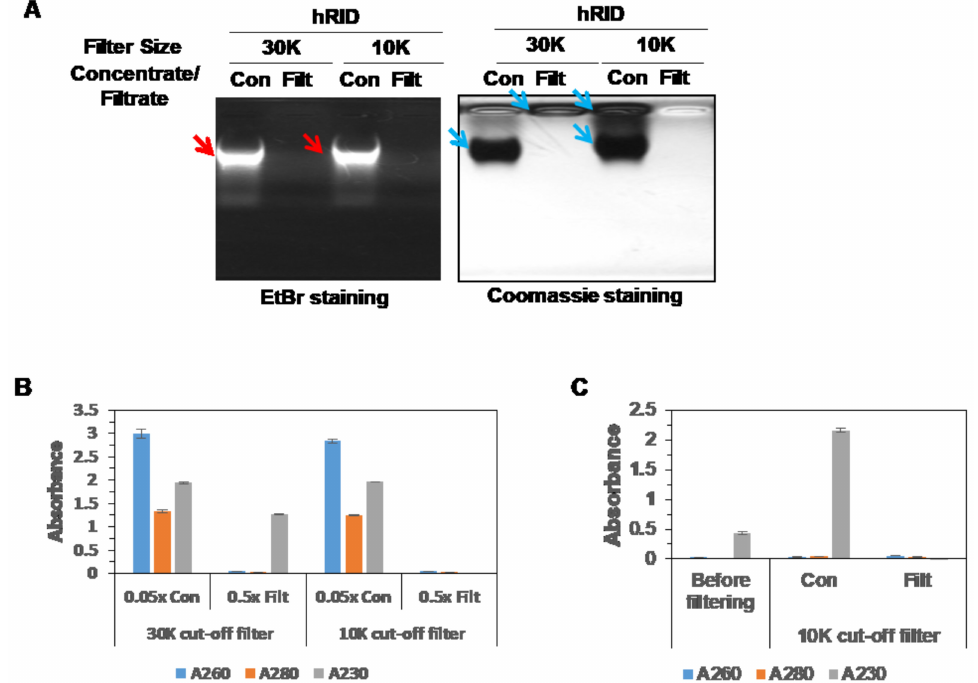
Figure 3. Purification of NA-free protein. ( A ) Purified hRID protein was tested for the removal of RNA after centrifugation through either 30K or 10K cut-off filters. Concentrated samples (Con) and filtrated samples (Filt) were analyzed by agarose gel electrophoresis. RNAs and proteins are indicated with red and blue arrows, respectively. ( B ) Absorbances of the samples in ( A ) at 260, 280, and 230 nm with the proper dilution. ( C ) NA-free hRID was concentrated using a 10K cut-off filter, and the absorbances at 260, 280, and 230 nm of 6-fold diluted samples were measured. The values in each graph represent the means ± standard deviations of the